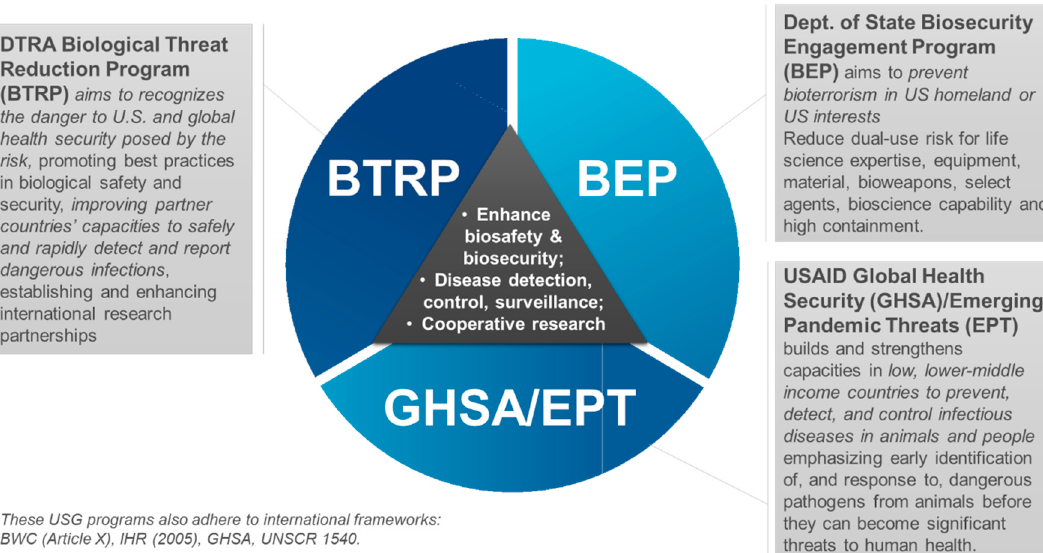
Figure 1. The governments of the US, Canada, Germany, and the United Kingdom fund programs that engage with over 40 countries worldwide to reduce biological threats. The countries represented are not necessarily engaged in current program activities.